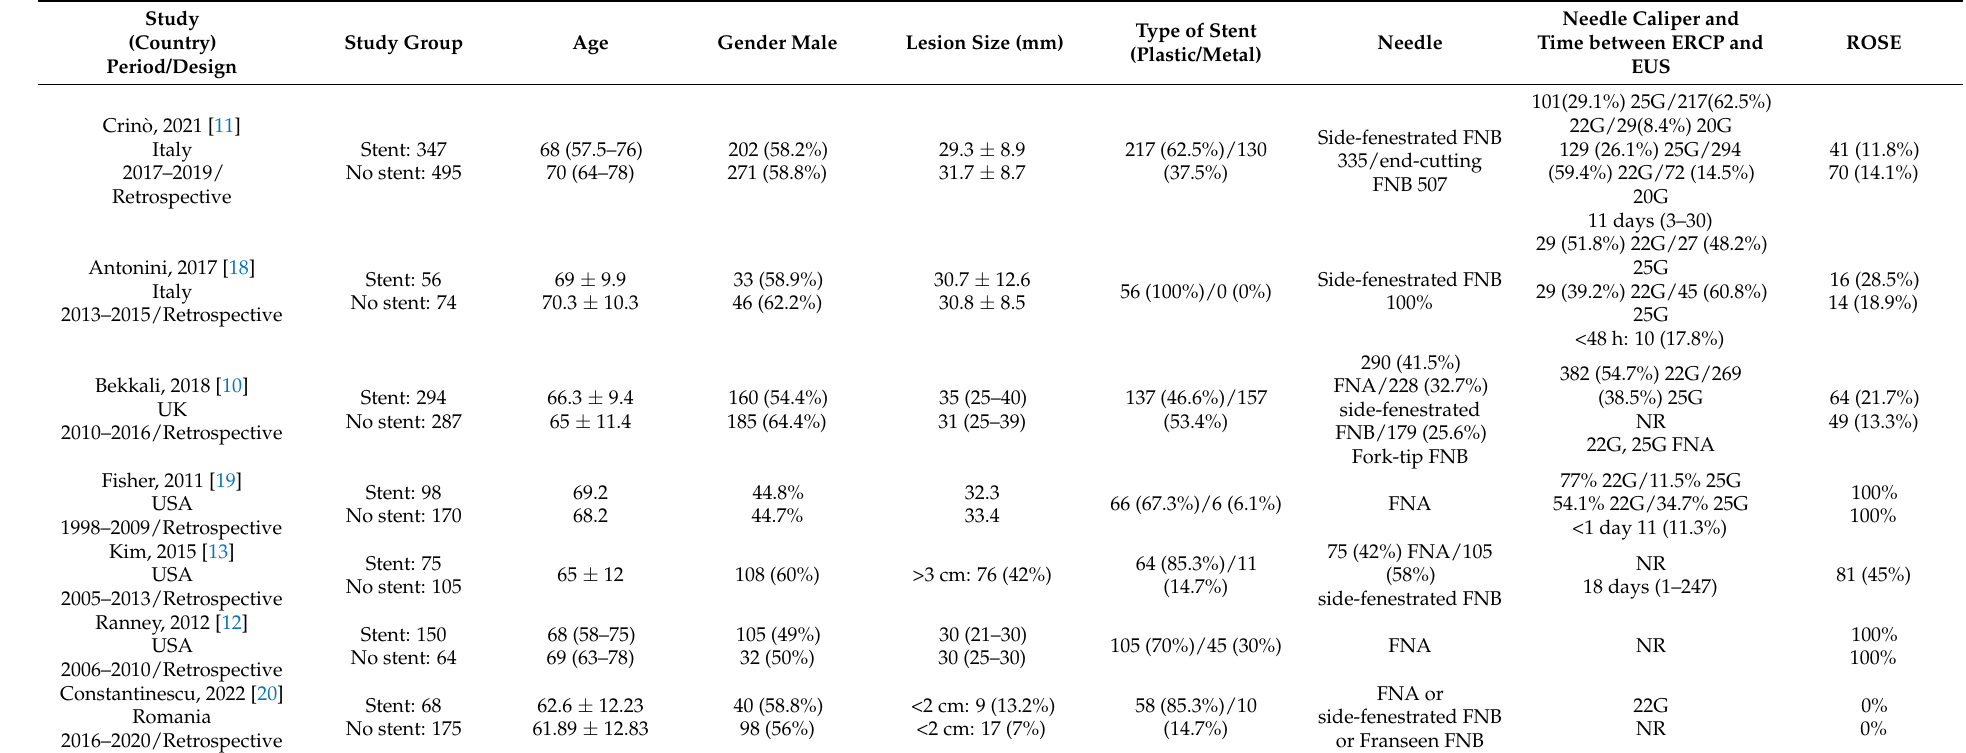
Table 1. Characteristics of included